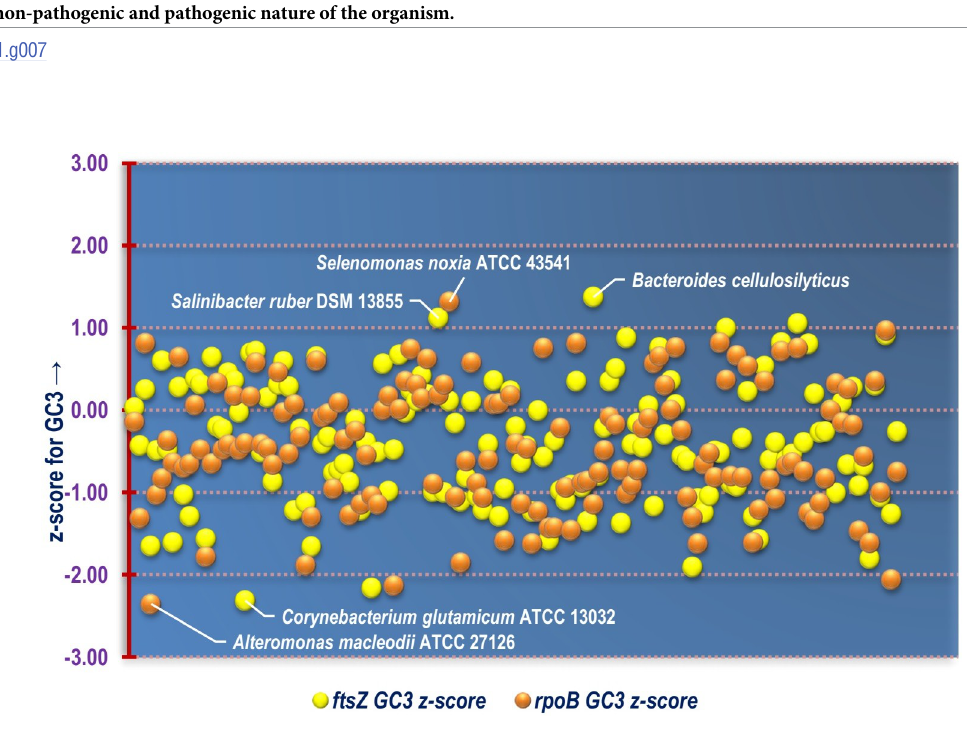
Fig 8. A scatter plot depicting the distribution of z-score for the GC3 of ftsZ and rpoB CDS of all the bacterial species included in this study. The name of the organisms with relatively higher and lower GC3 z-score have been labelled in the